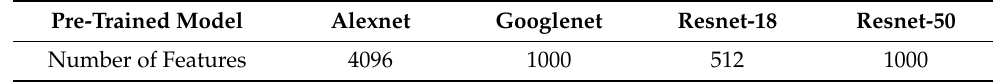
Table 2. Number of Features Extracted from Pre-Trained Models. Pre-Trained